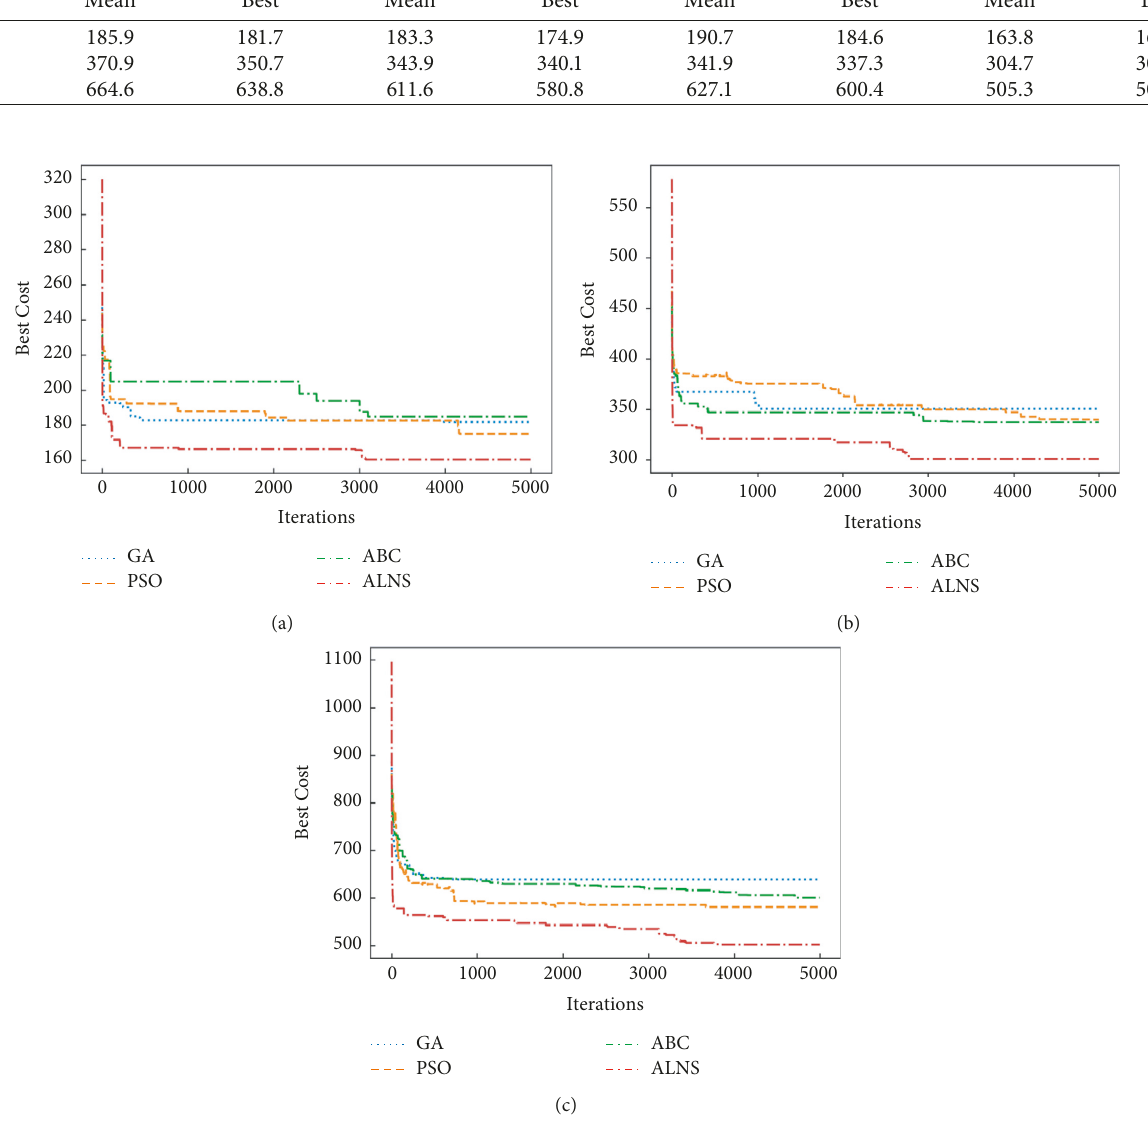
Table 11: Comparison of ALNS ip with the GA-SA, PSO, and ABC on the benchmark instances. GA PSO ABC ALNS ip No